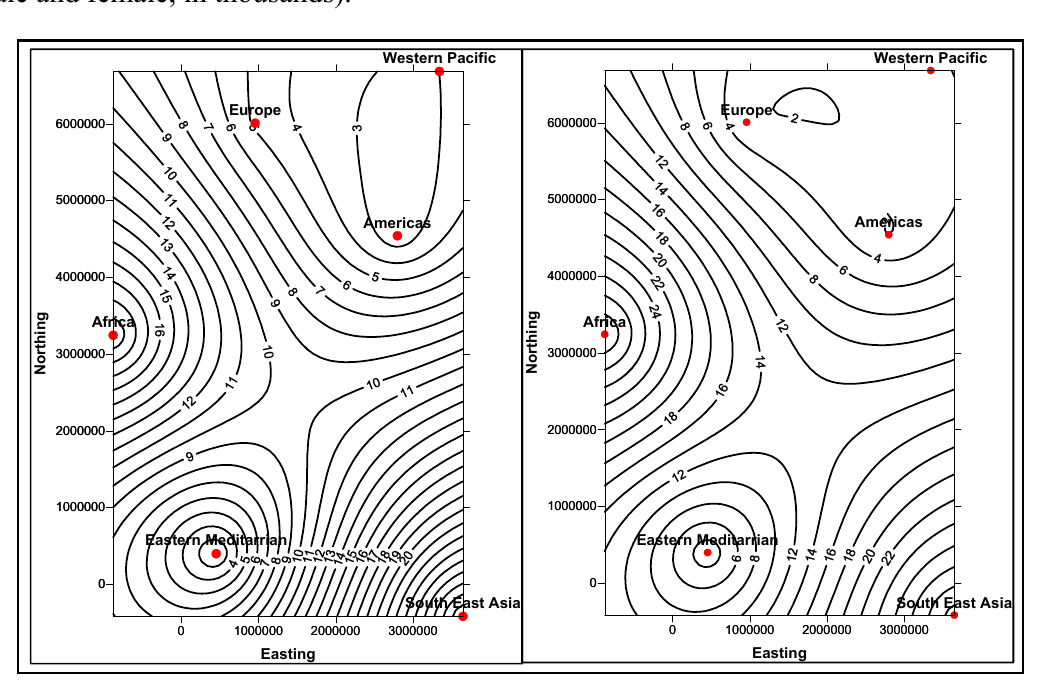
Figure 14. Map views for different regions showing diabetes deaths (0–34 age group of male and female, in thousands).